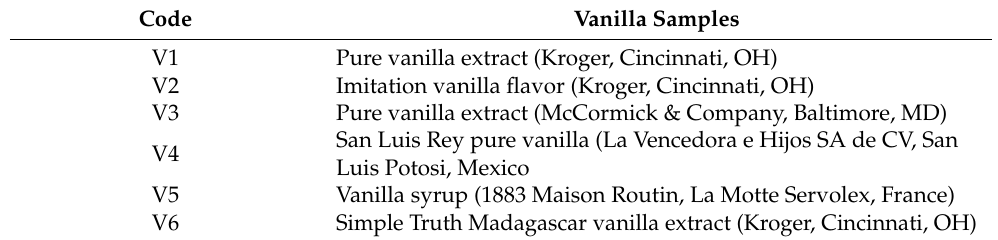
Table A2. Tested vanilla